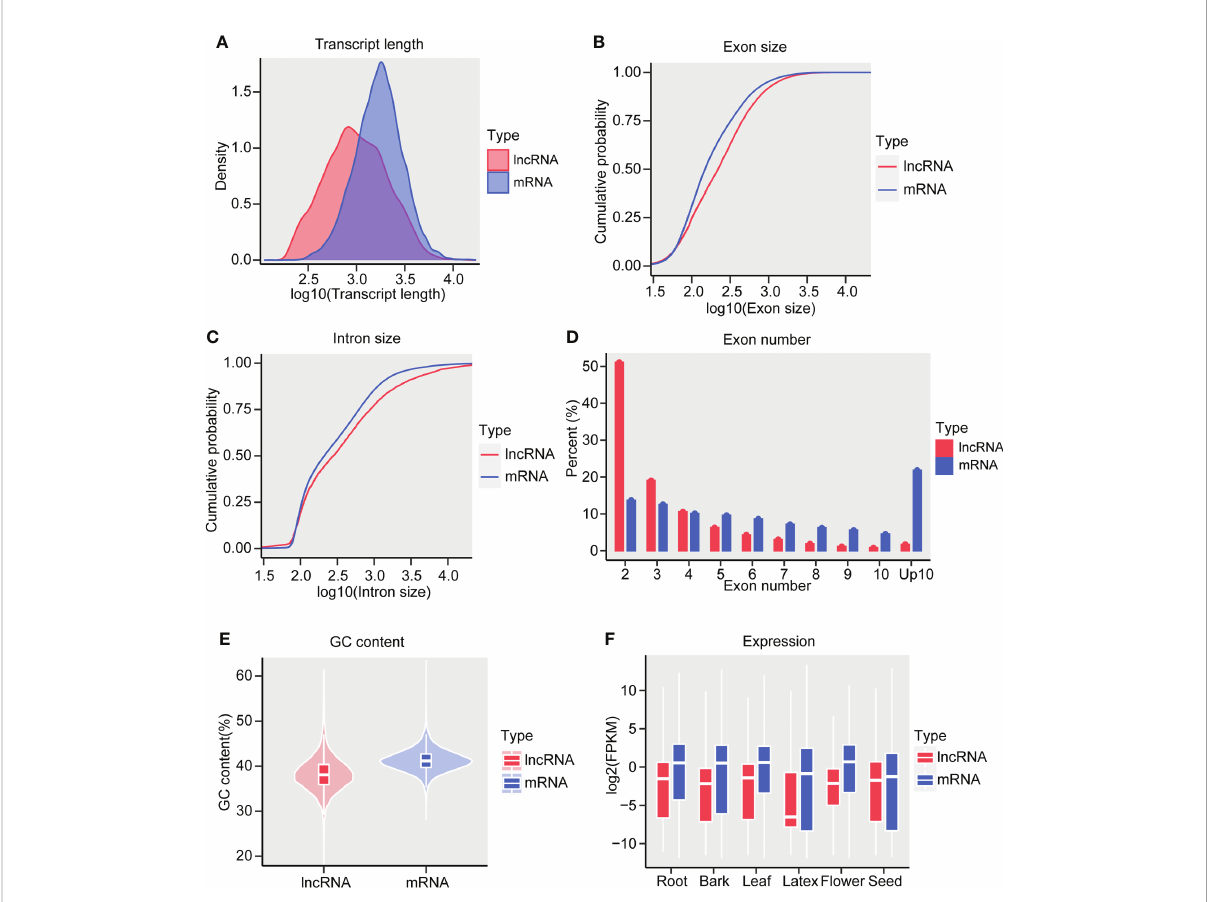
FIGURE 3 Characteristics of Hevea brasiliensis lncRNAs. (A) Density distribution of transcript length between lncRNA and mRNAs. The cumulative probability of (B) exon size and (C) intron size in lncRNAs and mRNAs. (D) Percent of lncRNAs and mRNAs in different exon numbers. (E) The GC content (%) of the lncRNAs and mRNAs. (F) The expression values of lncRNAs and mRNAs, Y axis indicate the expression value